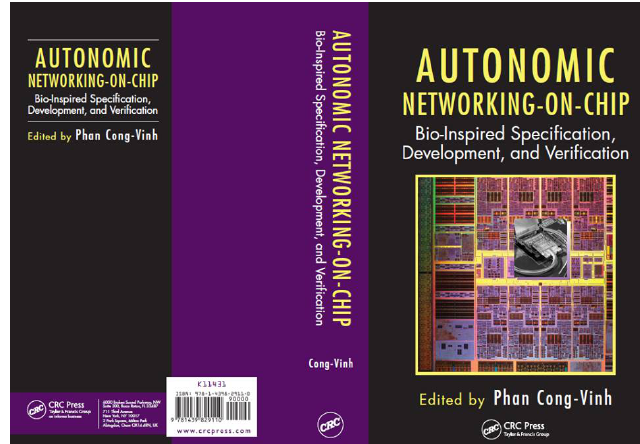
Figure 1. Cover of the